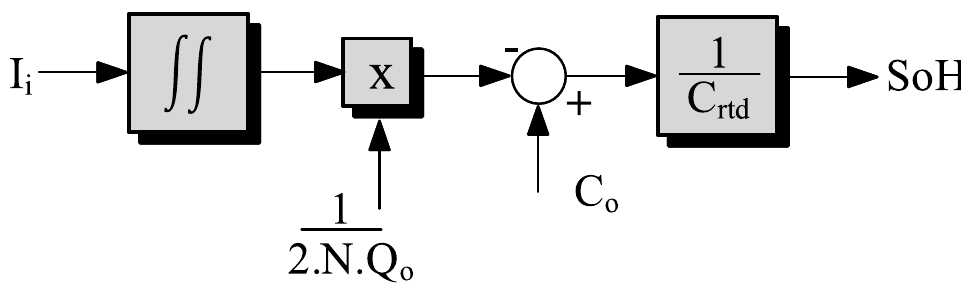
Figure 4. Block diagram for Capacity fade method.